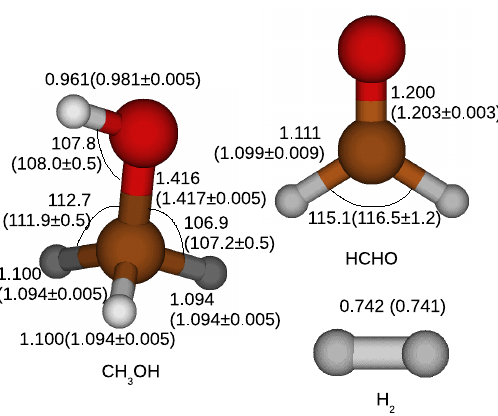
Figure 1. Optimized structures of a CH OH, an HCHO, and an H . Red, Gray, and brown solid 3 2 circles correspond to an oxygen atom, a hydrogen atom, and a carbon atom, respectively. Atoms are chemically connected with one another with a bond. The number next to a bond is the calculated bond length in the unit of Å with that determined by an experiment [20–22] in a parenthesis.